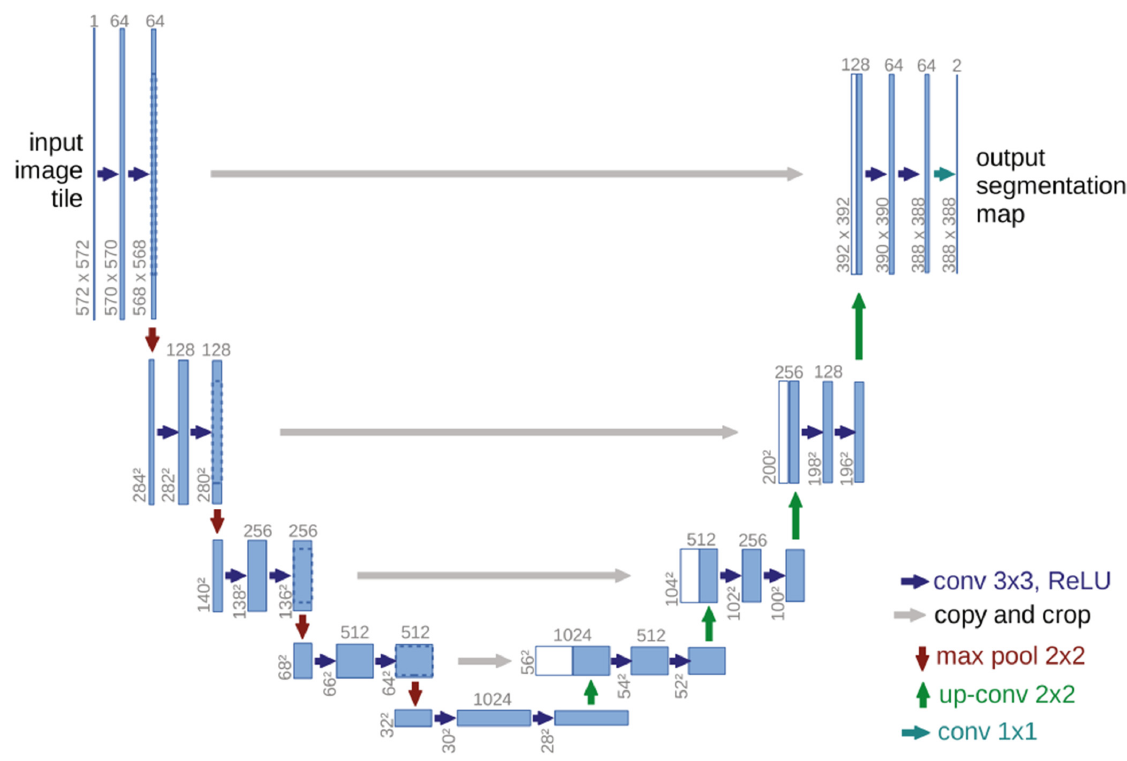
Figure 1. Overview of U-Net